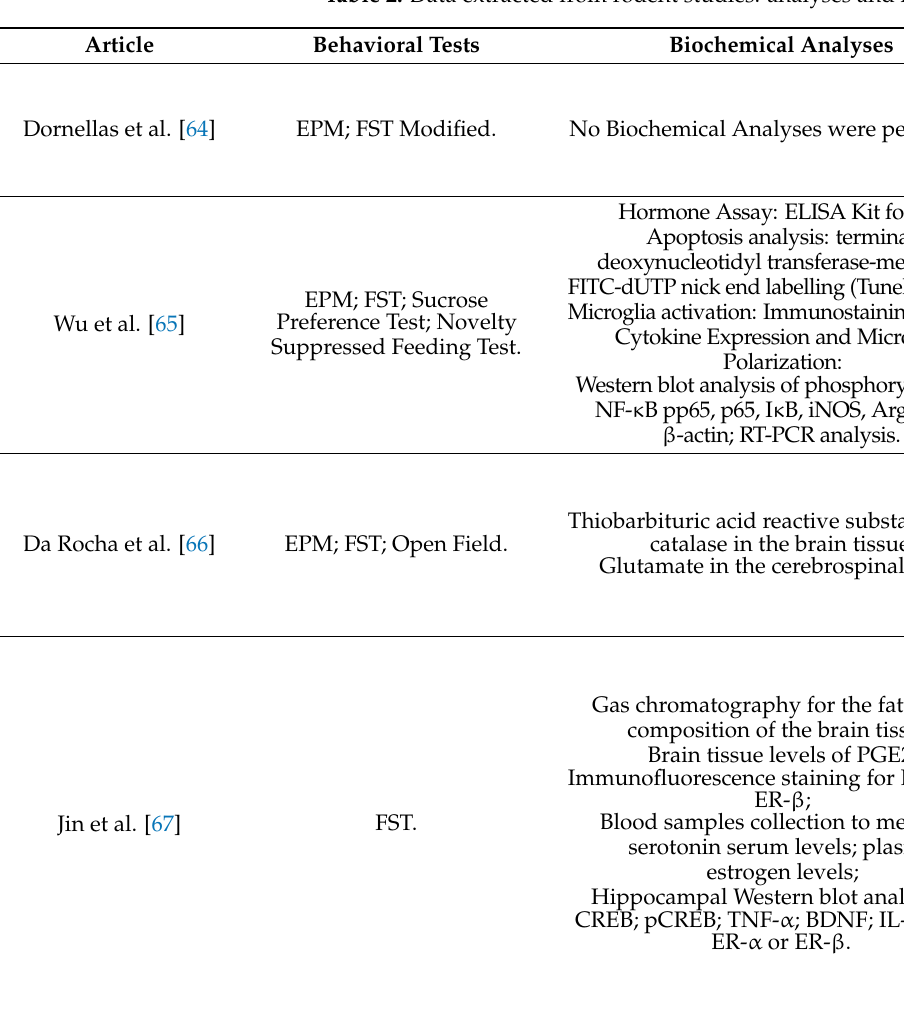
Table 2. Data extracted from rodent studies: analyses and main results of rodent